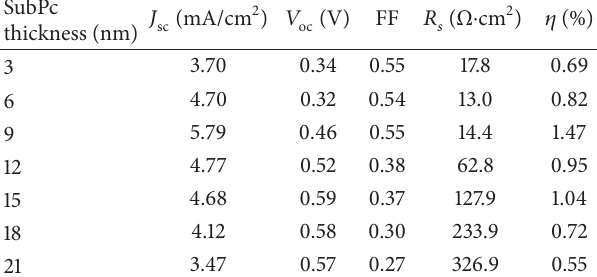
Figure 1: The configuration of device and the energy level diagram in the study.